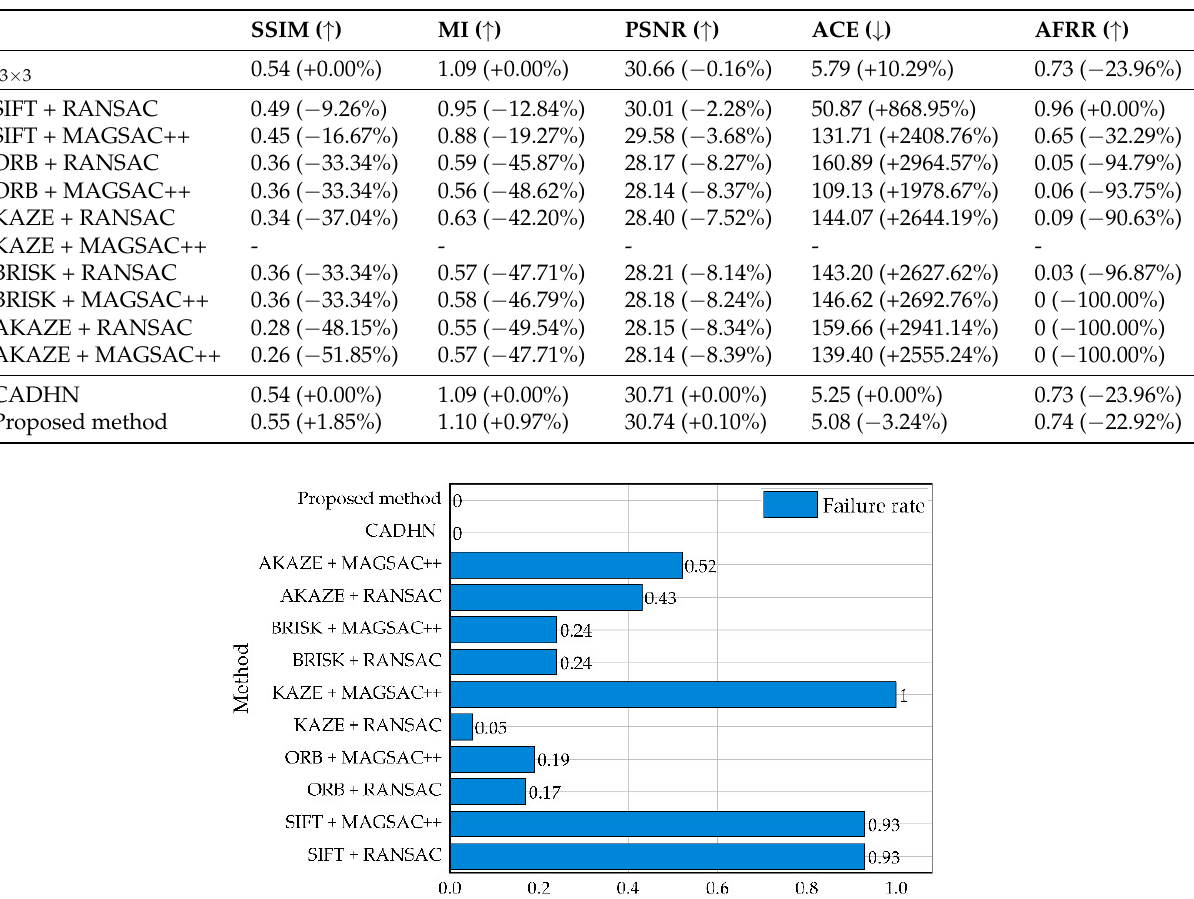
Table 4. Quantitative comparison on synthetic benchmark dataset. We mark the best method in red and the suboptimal method in blue. The rest of this article uses the same notation method.